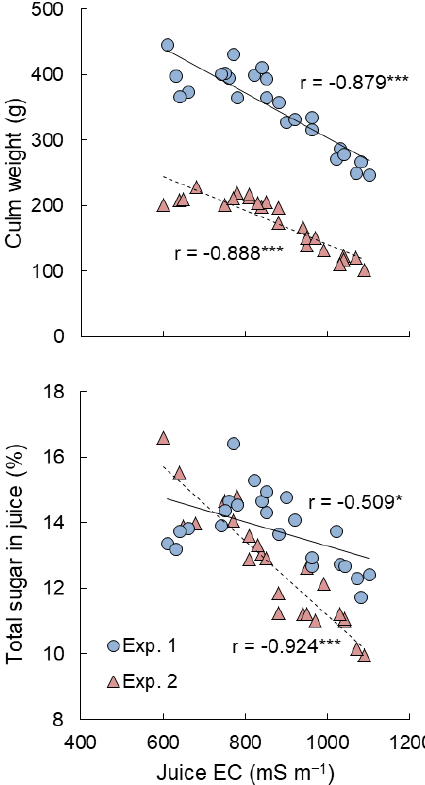
Figure 5. Relationships of juice EC with culm weight and total sugar concentration in juice. The linear trendlines for Exp. 1 (solid) and Exp. 2 (broken) and r values are shown in the graphs. * and *** denote significance at the 5% and 0.1% levels, respectively.